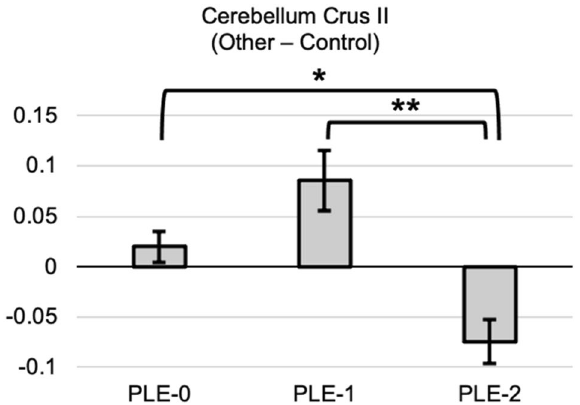
Figure 4. seed-based functional connectivity in the (Other—Control) contrast. Bar graphs showing the between-group functional connectivity results (PLE-0 = control trajectory; PLE-1 = decreasing